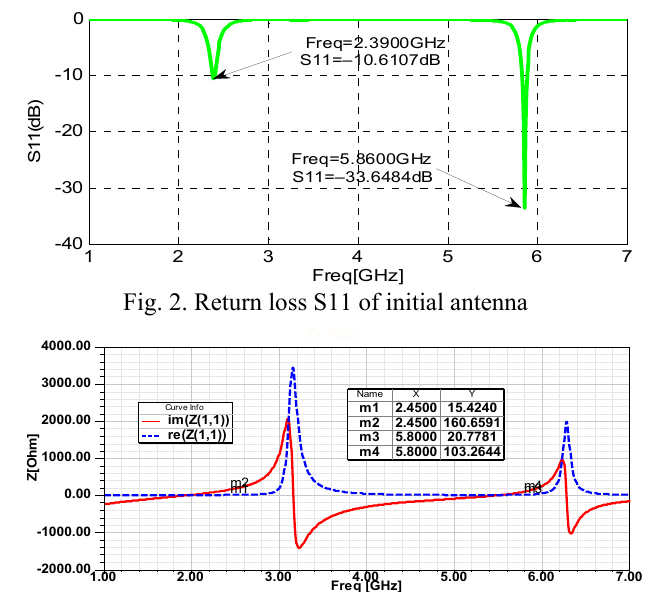
Fig. 3. Input impedance of initial